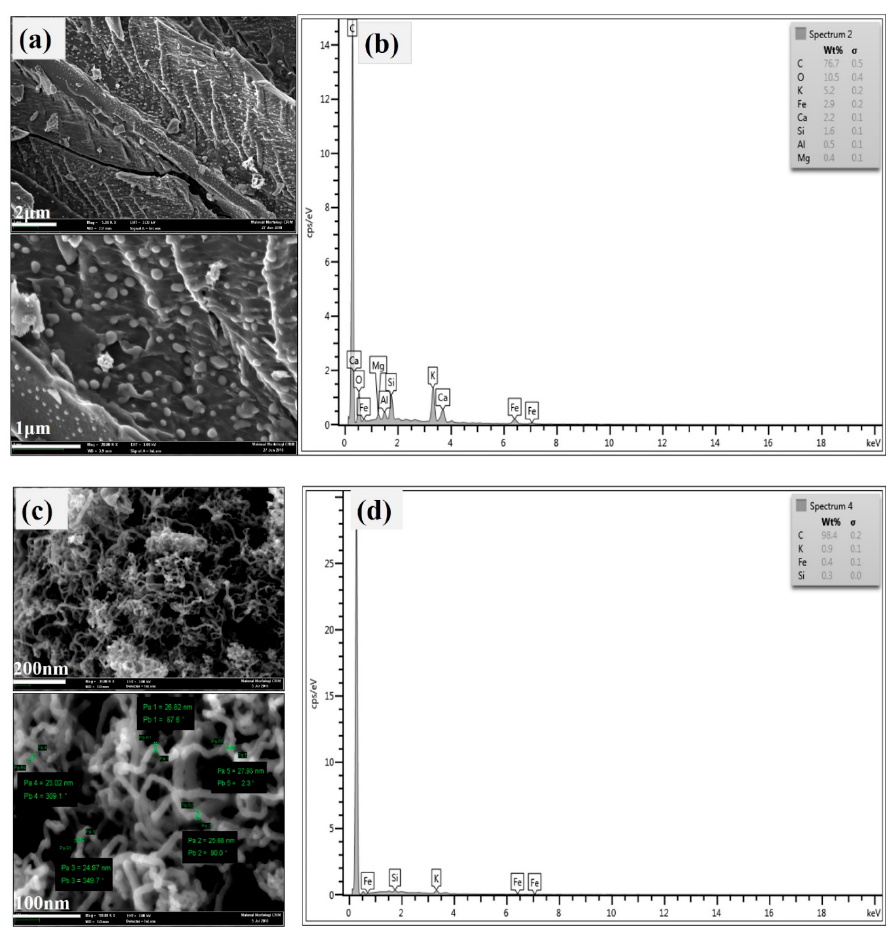
Figure 2. ( a ) FESEM (field emission scanning electron microscope) images; ( b ) EDX (energy-